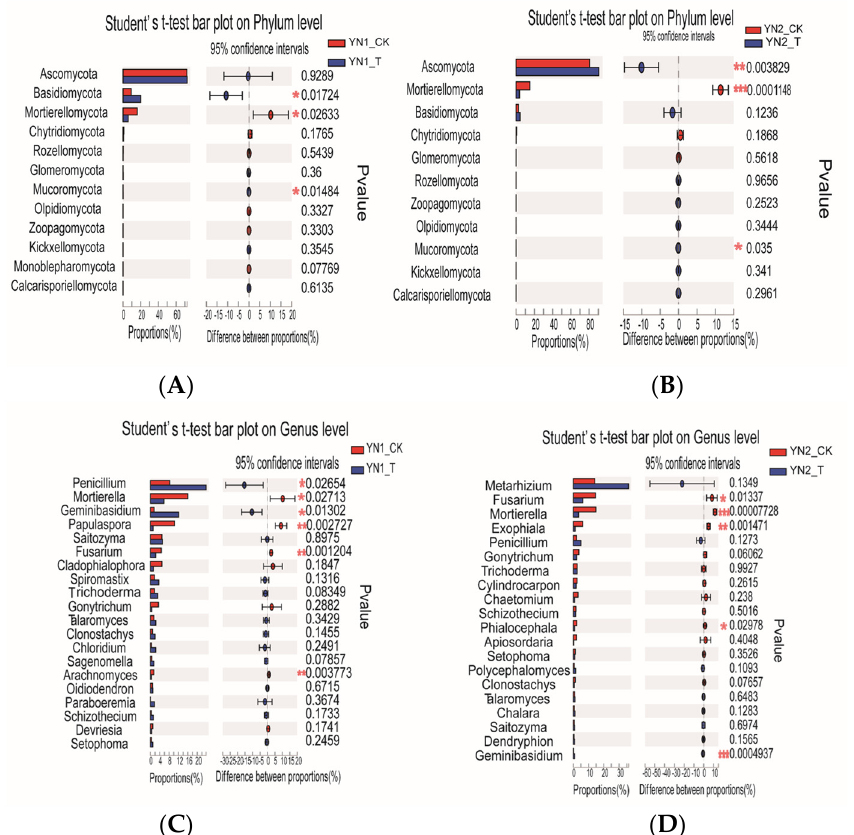
Figure 14. Changes in the relative abundance of ( A ) fungal phyla in YN1 soil; ( B ) fungal phyla YN2 soil; ( C ) fungal genera in YN1 soil; ( D ) fungal genera in YN2 soil. All soils were triple-fumigated and had been used to produce ginseng. ‘Triple fumigation’ refers to the simultaneous application of chloropicrin, dimethyl disulfide and metham sodium. The t -test reported the statistical differences (asterisked, * 0.01 < p ≤ 0.05; ** 0.001 < p ≤ 0.01; *** p ≤ 0.001.) between the means of three replicates within the phylum or genus levels.